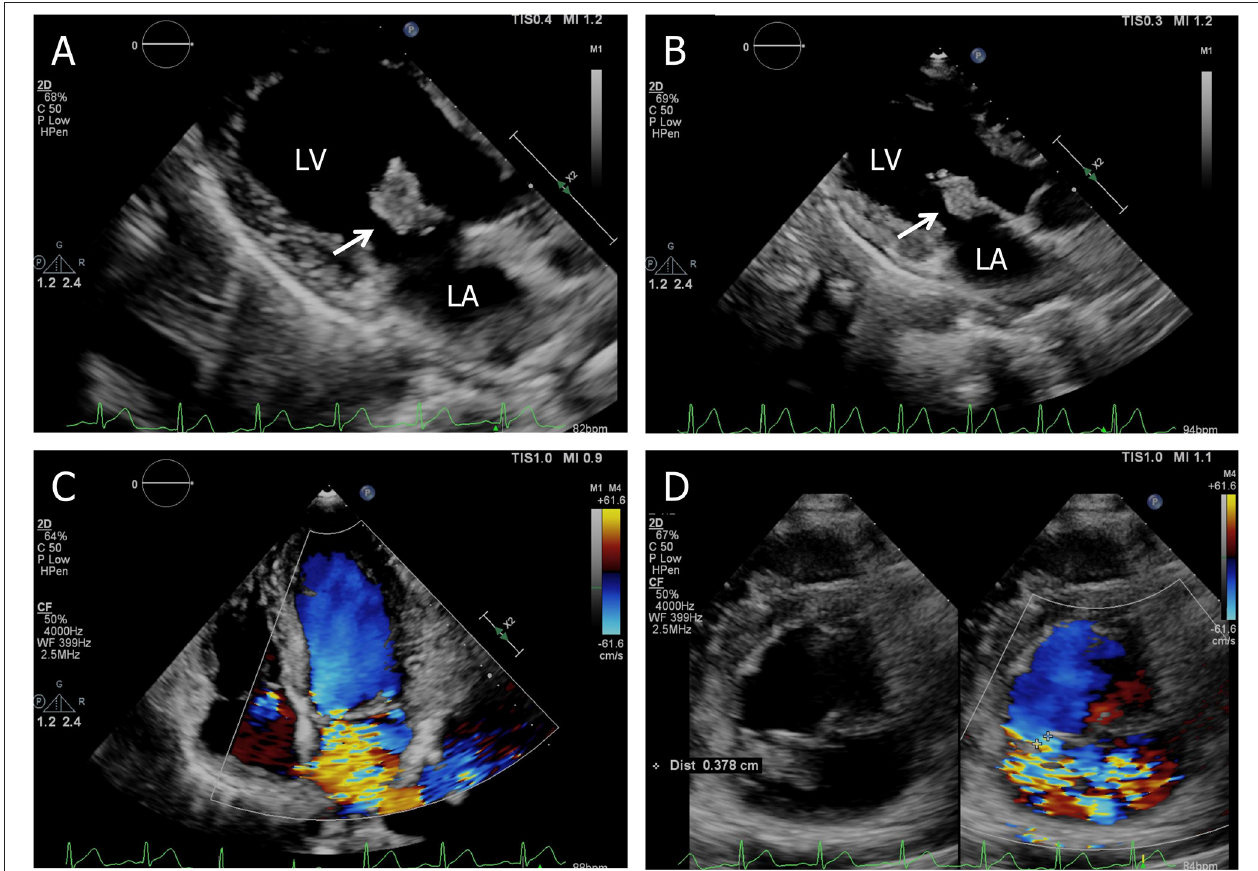
FIGURE 1 | Transthoracic echocardiogram. (A) Apical three-chamber view shows a 2.24 cm 2 vegetation in the anterior leaflet of the mitral valve, (B) the size of the vegetation decreased to 1.91 cm 2 on the 7th hospital day, (C) apical four-chamber view shows severe mitral regurgitation, and (D) short-axis parasternal view shows severe mitral regurgitation contrasted with color Doppler. LA, left atrium; LV, left